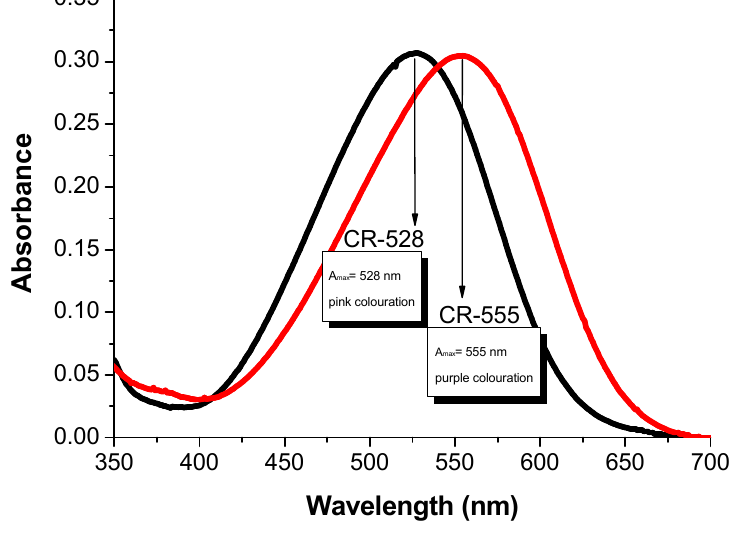
Figure 2. Absorption spectra of CR-528 (2.4 × 10 − 7 M) and CR-555 (2.6 × 10 − 7 M) in ethanol.